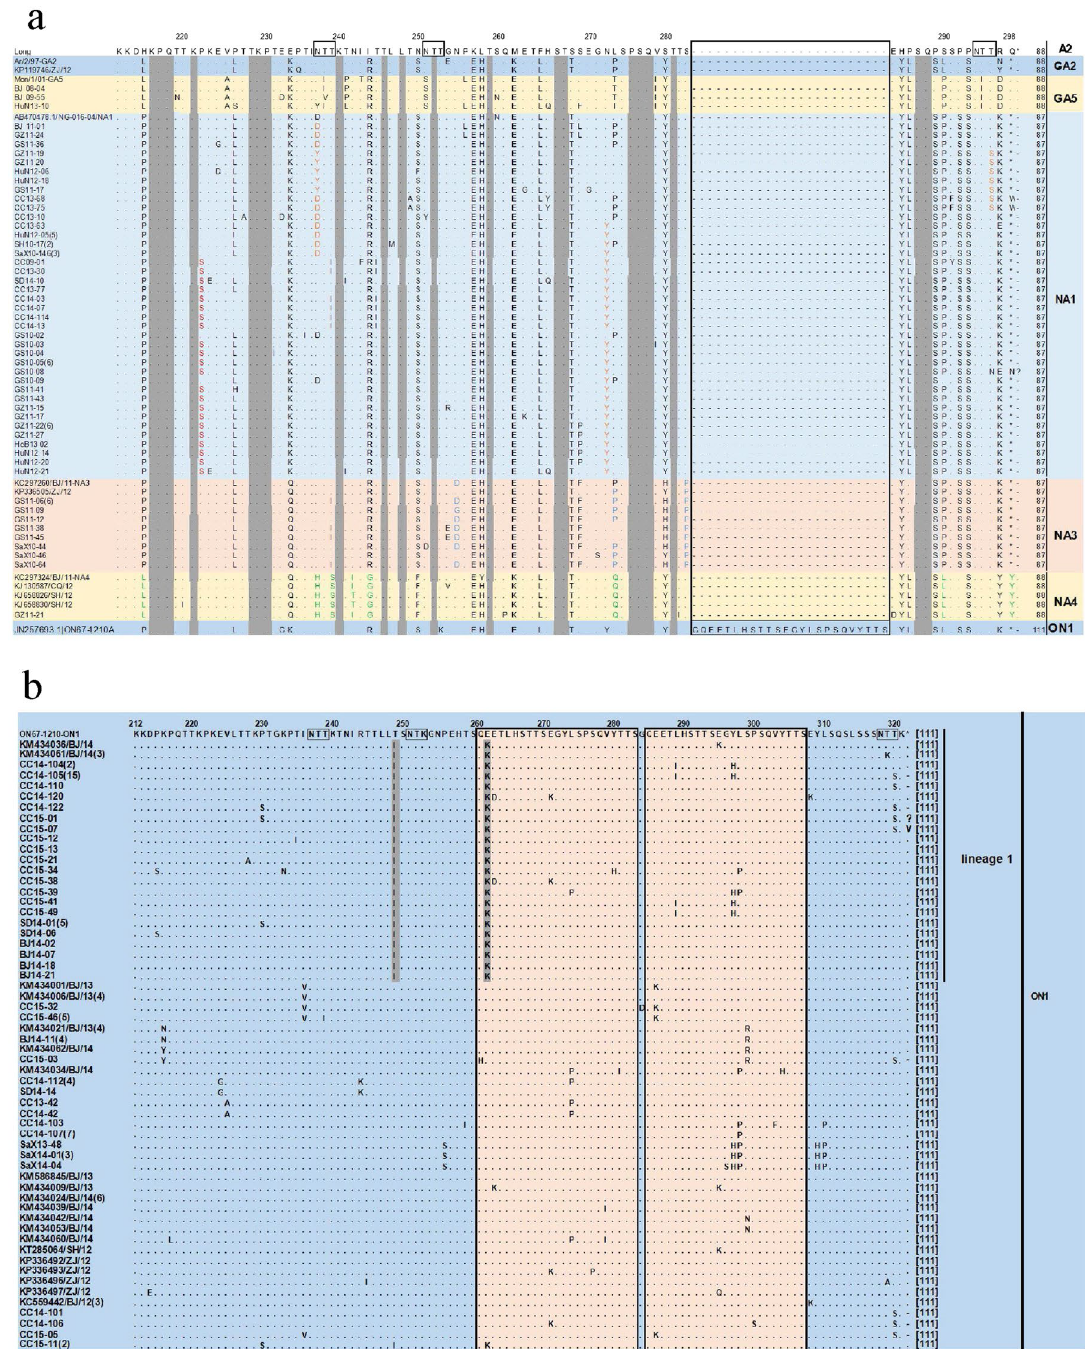
Figure 3. ( a ) Amino acid substitutions at the HVR2 region of the G protein in representative HRSVA sequences. Different background colors are used to facilitate visualization of different genotypes. Identical residues and stop codons are indicated by dots and asterisks, respectively; the lengths of the HVR2 region are shown next to the end of the sequences, followed by the genotype names. The regions shaded in grey represent the conserved regions among genotypes A2, GA2, GA5, NA1, NA3, NA4 and ON1. The box depicts the amino acid sequences corresponding to the 72-nucleotide duplication in the C-terminal of the G protein of the ON1 genotype. ( b ) Amino acid substitutions at the HVR2 region of the G protein in representative ON1 sequences. Some sequences clustered into lineage 1 due to the 2 substitutions of T249I and E262K, shaded in grey. The boxes depict the amino acid sequences corresponding to the 72-nucleotide duplication in the C-terminal of the G